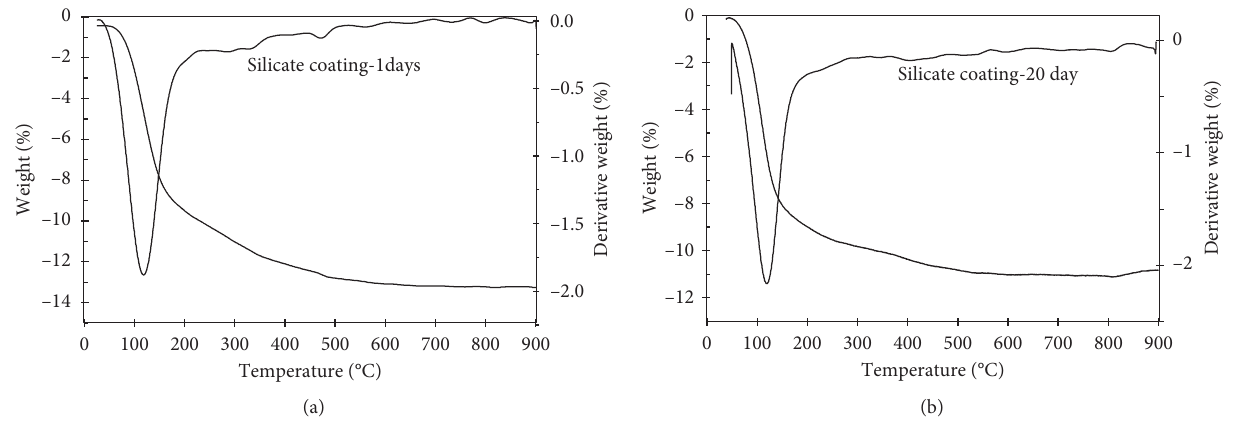
Figure 4: TGA and DTG curves of the stable mixing of silicate coating sample at 1 day (a); TGA and DTG curves of the stable mixing of silicate coating sample at 20 days (b).